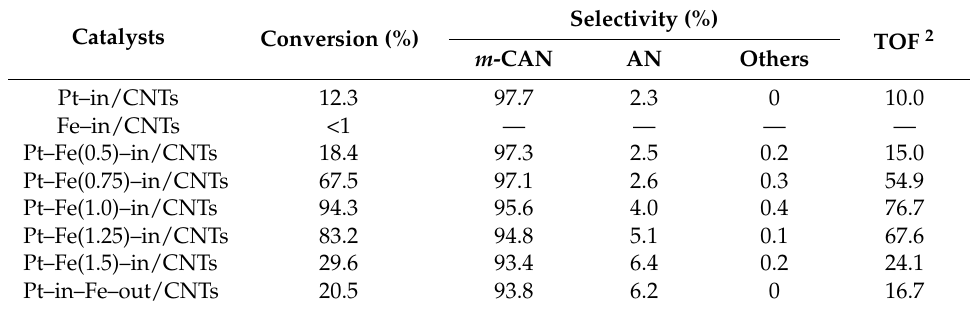
Table 3. The effect of Fe content on the in-situ hydrogenation of m -CNB over Fe–modified Pt–in/CNTs. 1.